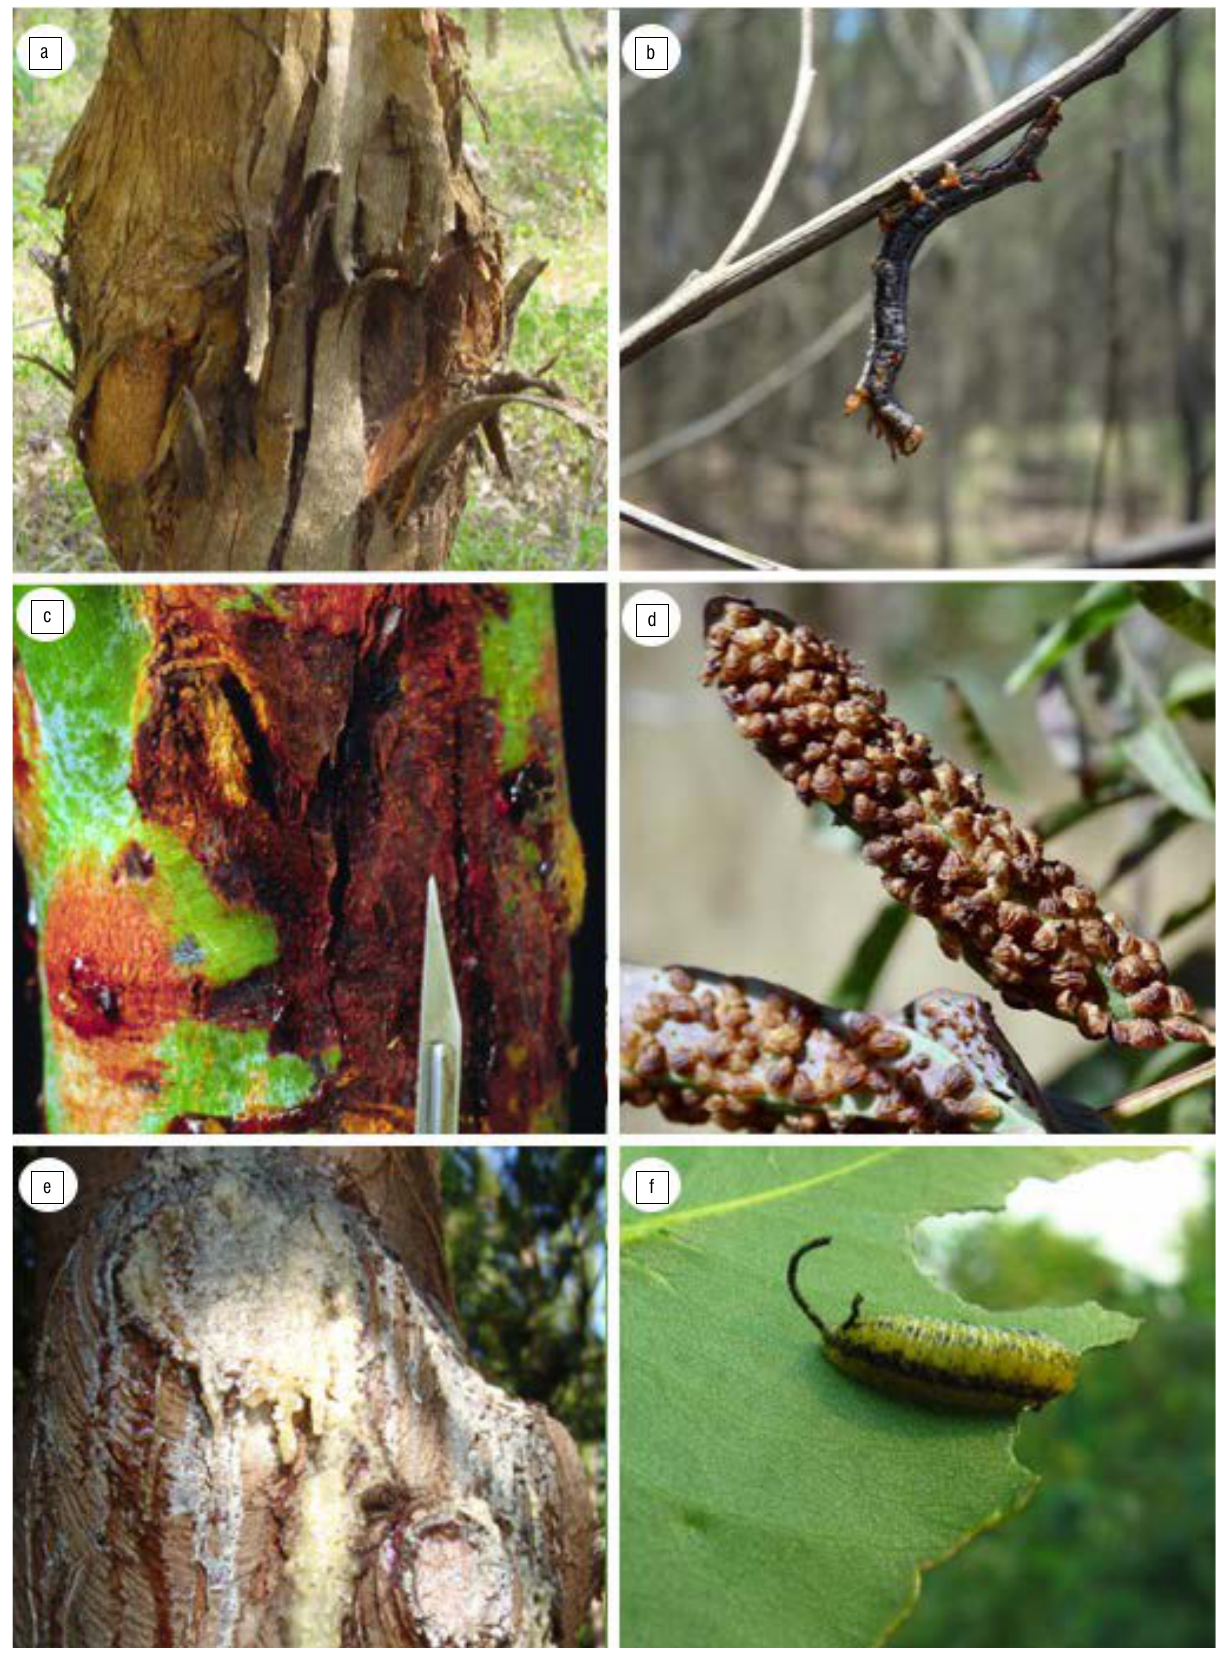
Figure 1: Pathogens and insect pests of plantation trees in South Africa: (a) Cryphonectria canker on Eucalyptus – one of the first serious diseases to emerge in South African clonal forestry; (b) the wattle semi-looper, Achaea lineardi , a native insect and sporadic pest of Acacia mearnsii ; (c) symptoms of Coniothyrium canker caused by Teratosphaeria zuluensis on a susceptible Eucalyptus clone; (d) the shell lerp psyllid, Spondyliaspis c.f. plicatuloides , a recently introduced pest of Eucalyptus ; (e) canker on pine stem with resin bleeding caused by the pitch canker fungus Fusarium circinatum ; (f) larva of the eucalypt snout beetle, Gonipterus sp. n. 2, feeding on Eucalyptus